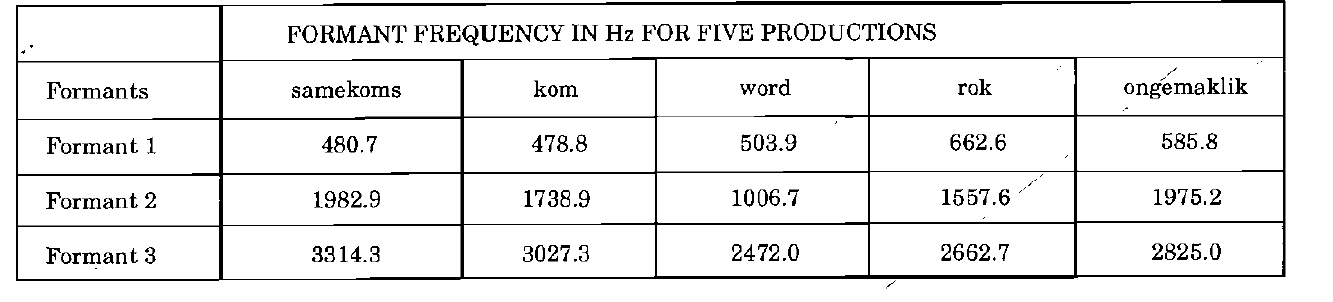
TABLE 8: The formant frequencies of five productions of [ ] in similar phonetic